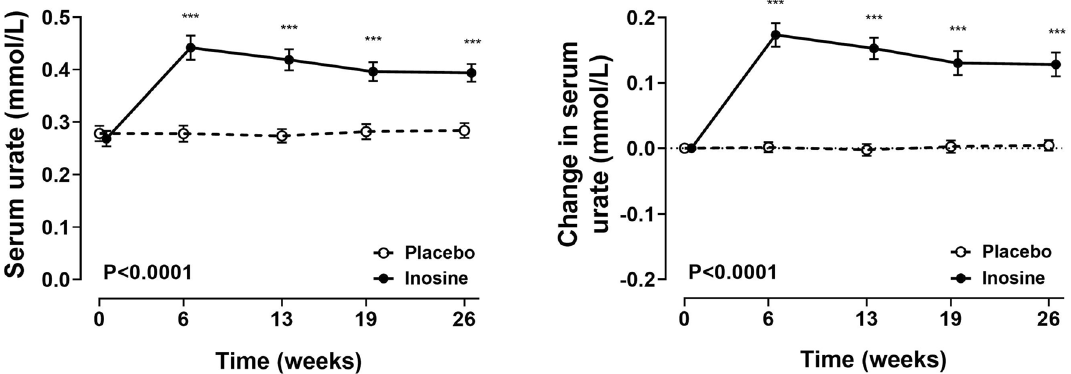
Figure 1. Serum urate. Absolute values (left panel) and change from baseline (right panel). Absolute serum urate values have been reported previously 10 . Data are shown as mean (95% CI), with P time×treatment . False discovery rate ***P <